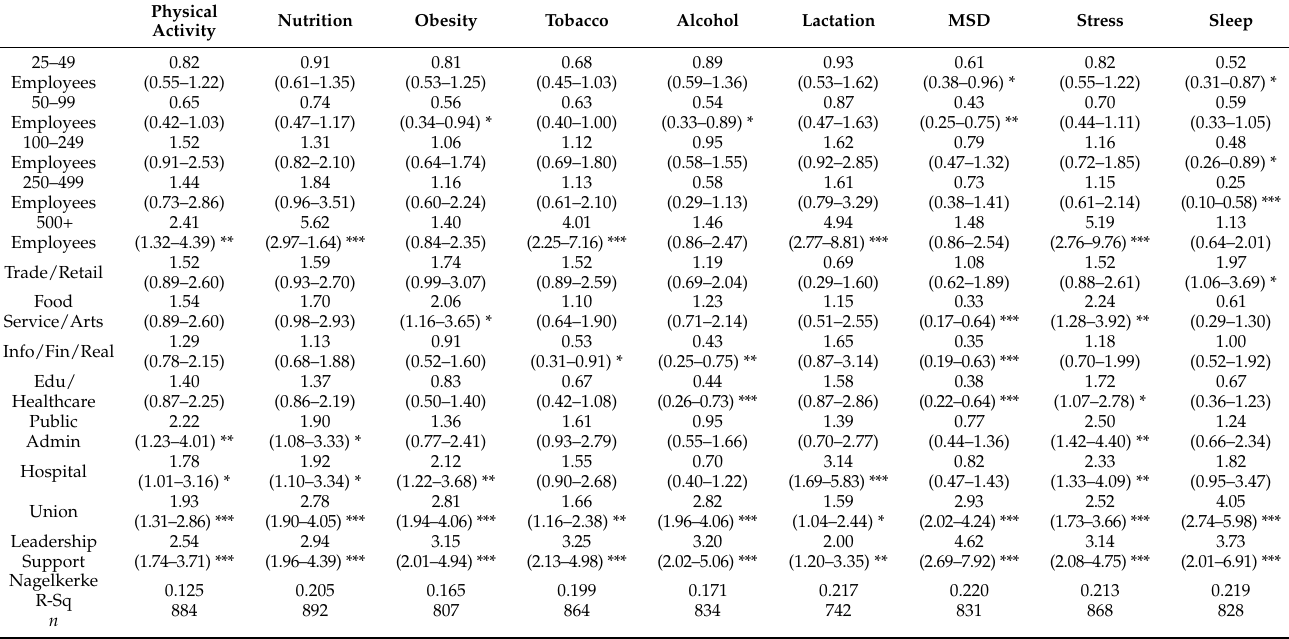
Table 4. Logistic regression with odds ratios (95% confidence